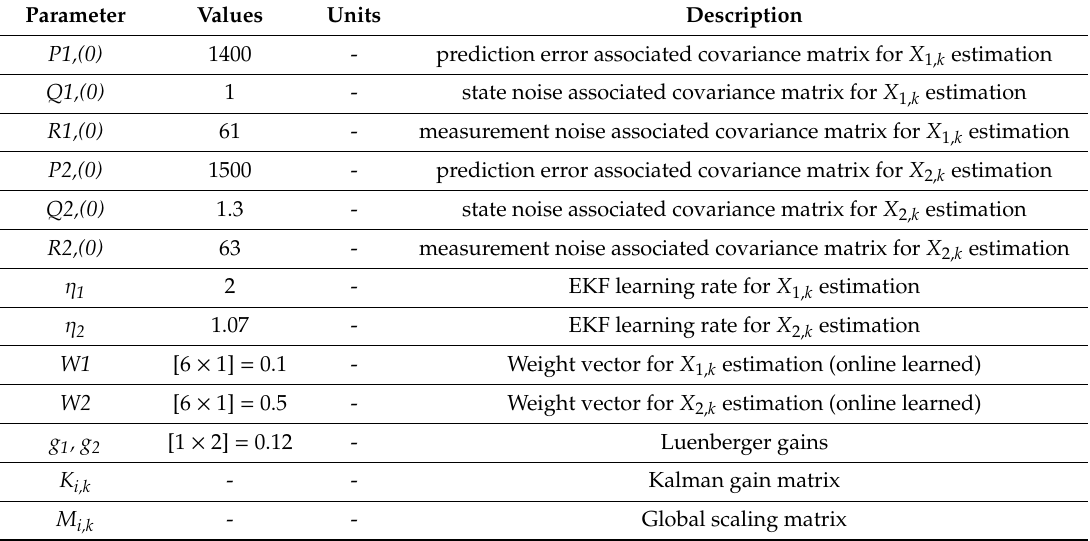
Table A3. Neural observer